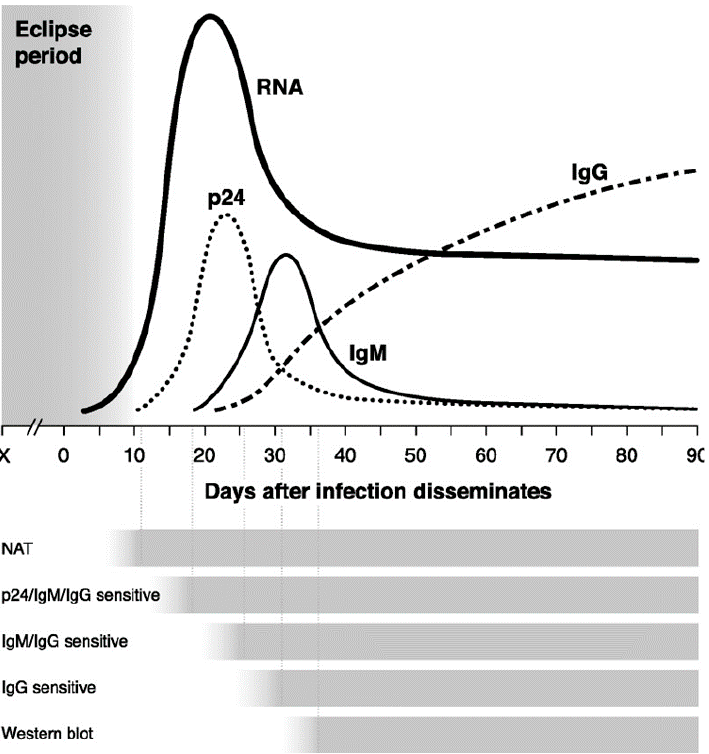
Figure 1. Timeline of virologic and serologic events associated with HIV infection. The length of time between when exposure to the virus occurs and there is dissemination of HIV is systemically dependent upon the manner in which the virus is acquired. The eclipse period represents the time from the exposure event to the first detectable marker of infection—when HIV RNA appears in the blood. Times to reactivity for each type of diagnostic test are depicted under the graph, from the earliest one—the nucleic acid amplification test (NAT)—to the latest assay system (test for IgG antibodies). A Western blot (or immunoblot) is used to confirm an initial positive result from a standard serologic test such as an ELISA. This latter aspect of the serologic algorithm is to ensure that an initial serologically-derived positive test result is not a false-positive. A Western blot is also not supposed to be used initially as a screening test, irrespective of the patient presentation, primarily for cost-containment purposes. Adapted from Maag, 2021 [7].